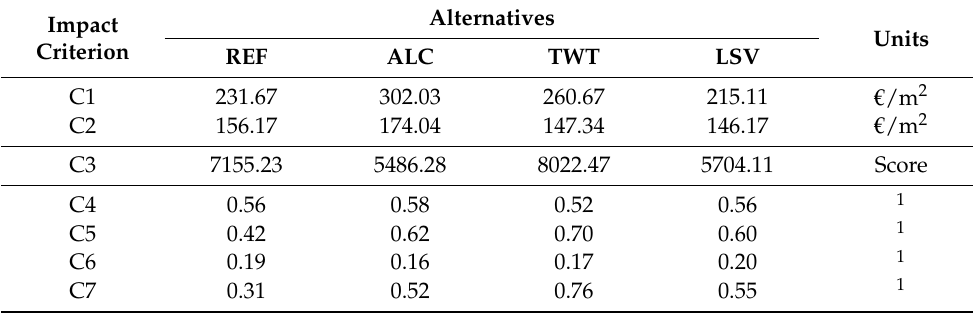
Table 4. Impacts of each of the design options considered.